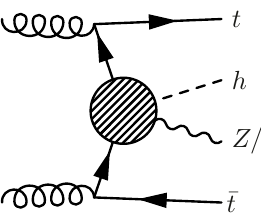
Figure 36. Schematic Feynman diagram for the EW-induced t (cid:22) t ( Z=(cid:13) ) h processes and their em- beddings of the t Z t h and t (cid:13) t h ! !